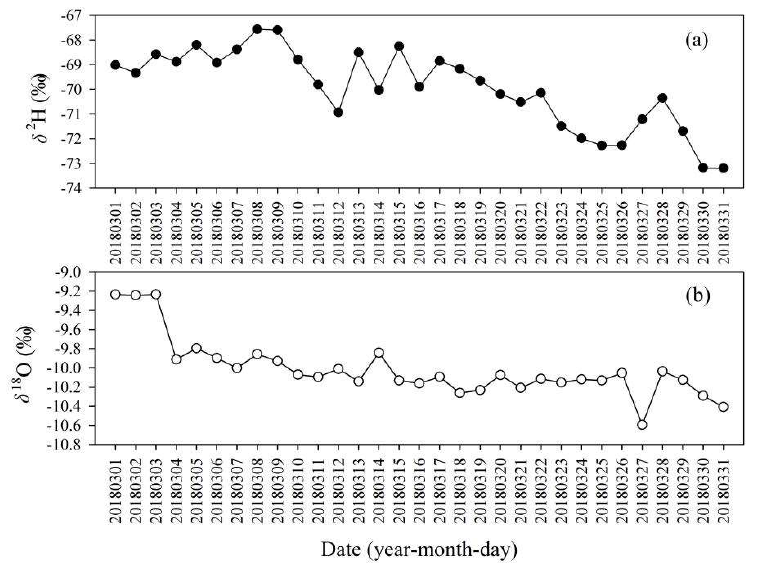
Figure 5. Daily variations of stable isotope ratios in tap water at the sampling site of Qiujiawan (T-4) in Lanzhou from March 1, 2018 to March 31, 2018. ( a ) δ 2 H, ( b ) δ 18 O.